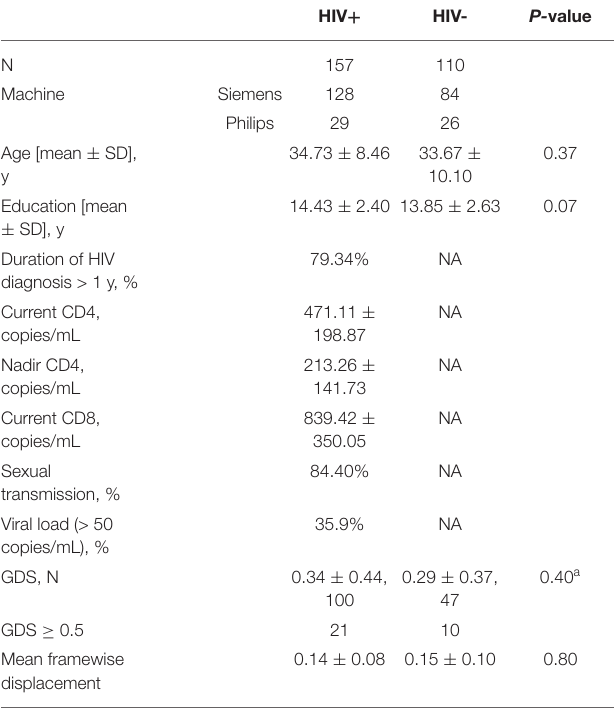
TABLE 1 | Demographics, neuropsychological and clinical